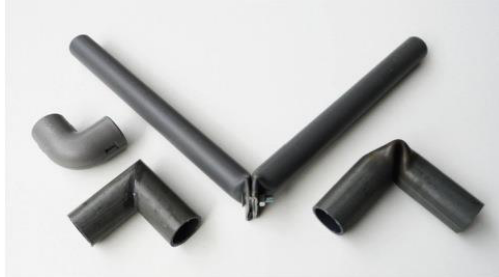
Figure 5 . Alternative ways to create a 90° joint, listed by Modular vegetable protection cage